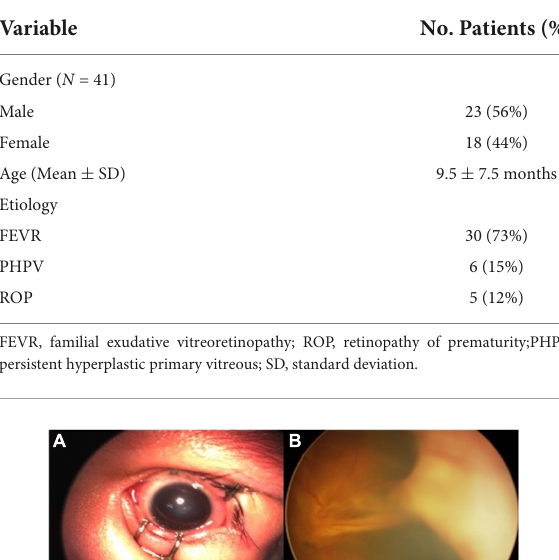
FIGURE1 The major steps of the iris incision. The iris incision was performed using the 20G vitrectomy microsurgical knife through a corneal incision (A,B) . After the puncture, the iris incision (red arrow) was observed (C) . The posterior aqueous humor (yellow arrow) flowed out from the incision (D) . The diagram shows that the posterior chamber fluid flows into the anterior chamber through the 27G iris incision, and fluid in the anterior chamber also outflows through the incision on the corneal limbus (E) .